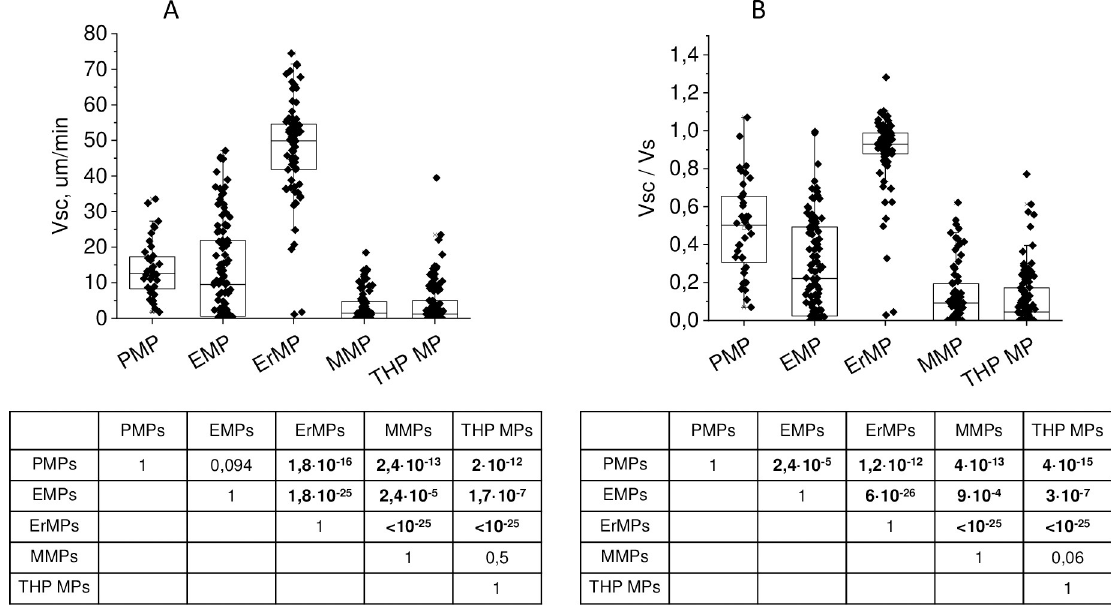
Fig 7. The rate of coagulation front propagation from centres of spontaneous clots induced by MPs of different origin and its ratio to the clot growth rate from activator. (A) Mean rate of coagulation front propagation from centres of spontaneous clots. (B) Mean ratio of the rate of coagulation front propagation from the centres of spontaneous clots to the clot growth rate from the activator. Dots correspond to individual clots induced by different MP samples at different concentrations. Boxes on the plot bound the 25th and the 75th percentiles. Tables under histograms contain the significance levels of corresponding parameter differences between MP of different origins according to the Mann–Whitney test.